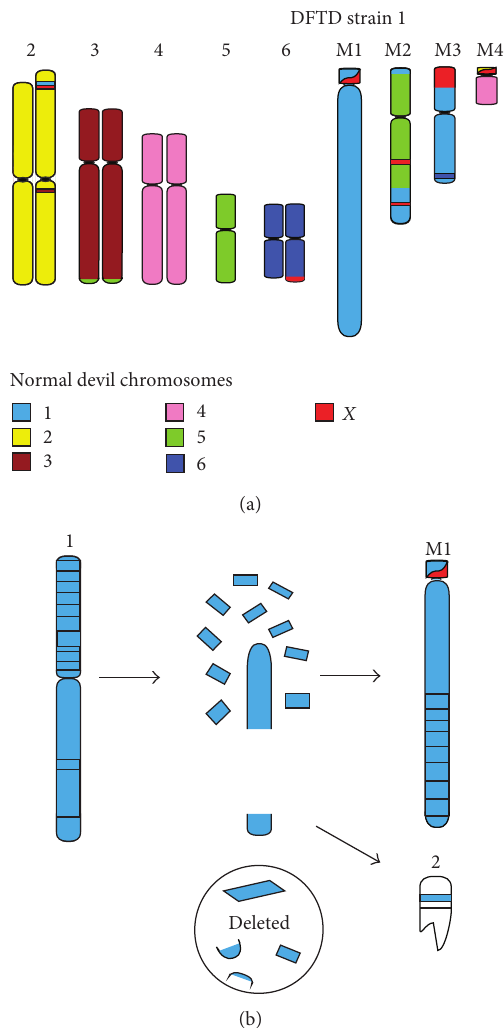
F 5: (a) Schematic of DFTD strain 1 karyotype.